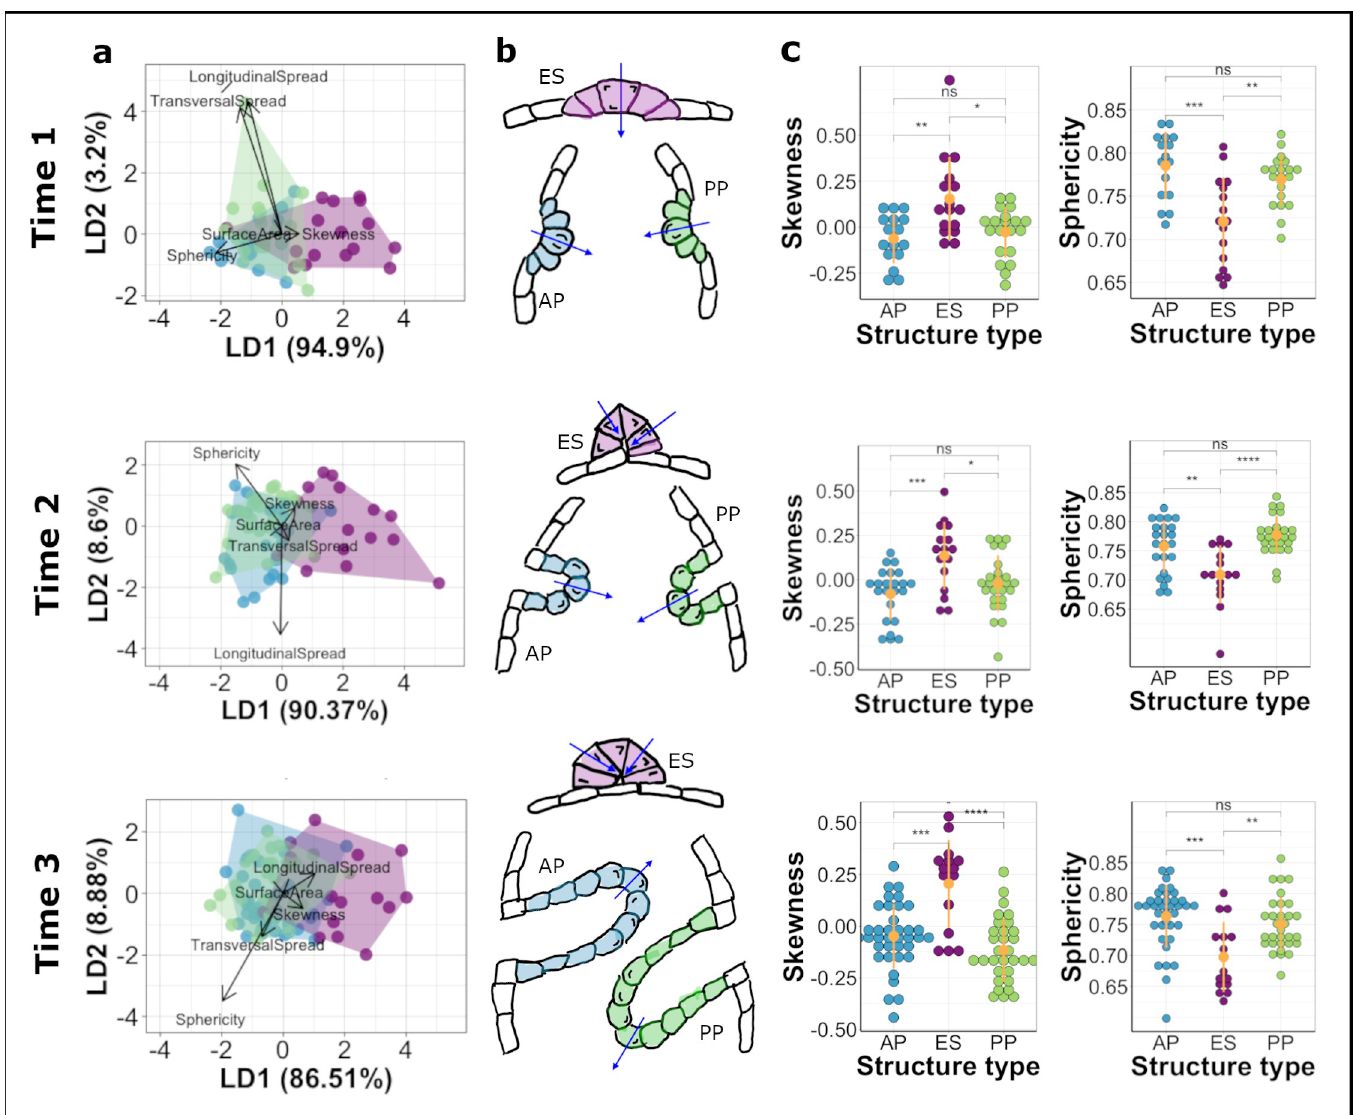
Fig 3. Comparison of shape dynamics in developing structures of the zebrafish inner ear. Rows represent each time point analysed. Data in blue represent cells from AP, green represent cells from PP and magenta represent ES. a. Linear discriminate analysis (LDA) biplots illustrate multivariate clustering of data—data from AP and PP show considerable overlap indicating similar shape signatures while data from ES show less overlap with the former. b. Schematic illustrations of cell shape signatures at the time points analysed showing cells in the ES having skew in the opposite direction to those in the projections and having less rounded shapes. Arrows indicate apico- basal polarity. c. Plots showing differences in skewness and sphericity between the structures at the time points analysed. Yellow dots with error lines represent mean and standard deviation for the data. p values for paired comparisons depicted are from Table